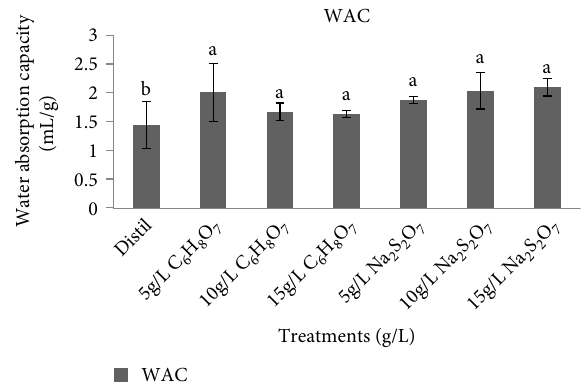
Figure 4: Effect of pretreatment on water absorption capacity of Ndou sweet potato flour. Distil= distilled water, C S O = sodium metabisulphite. and Na 2 2 7 S O = 2 2 7